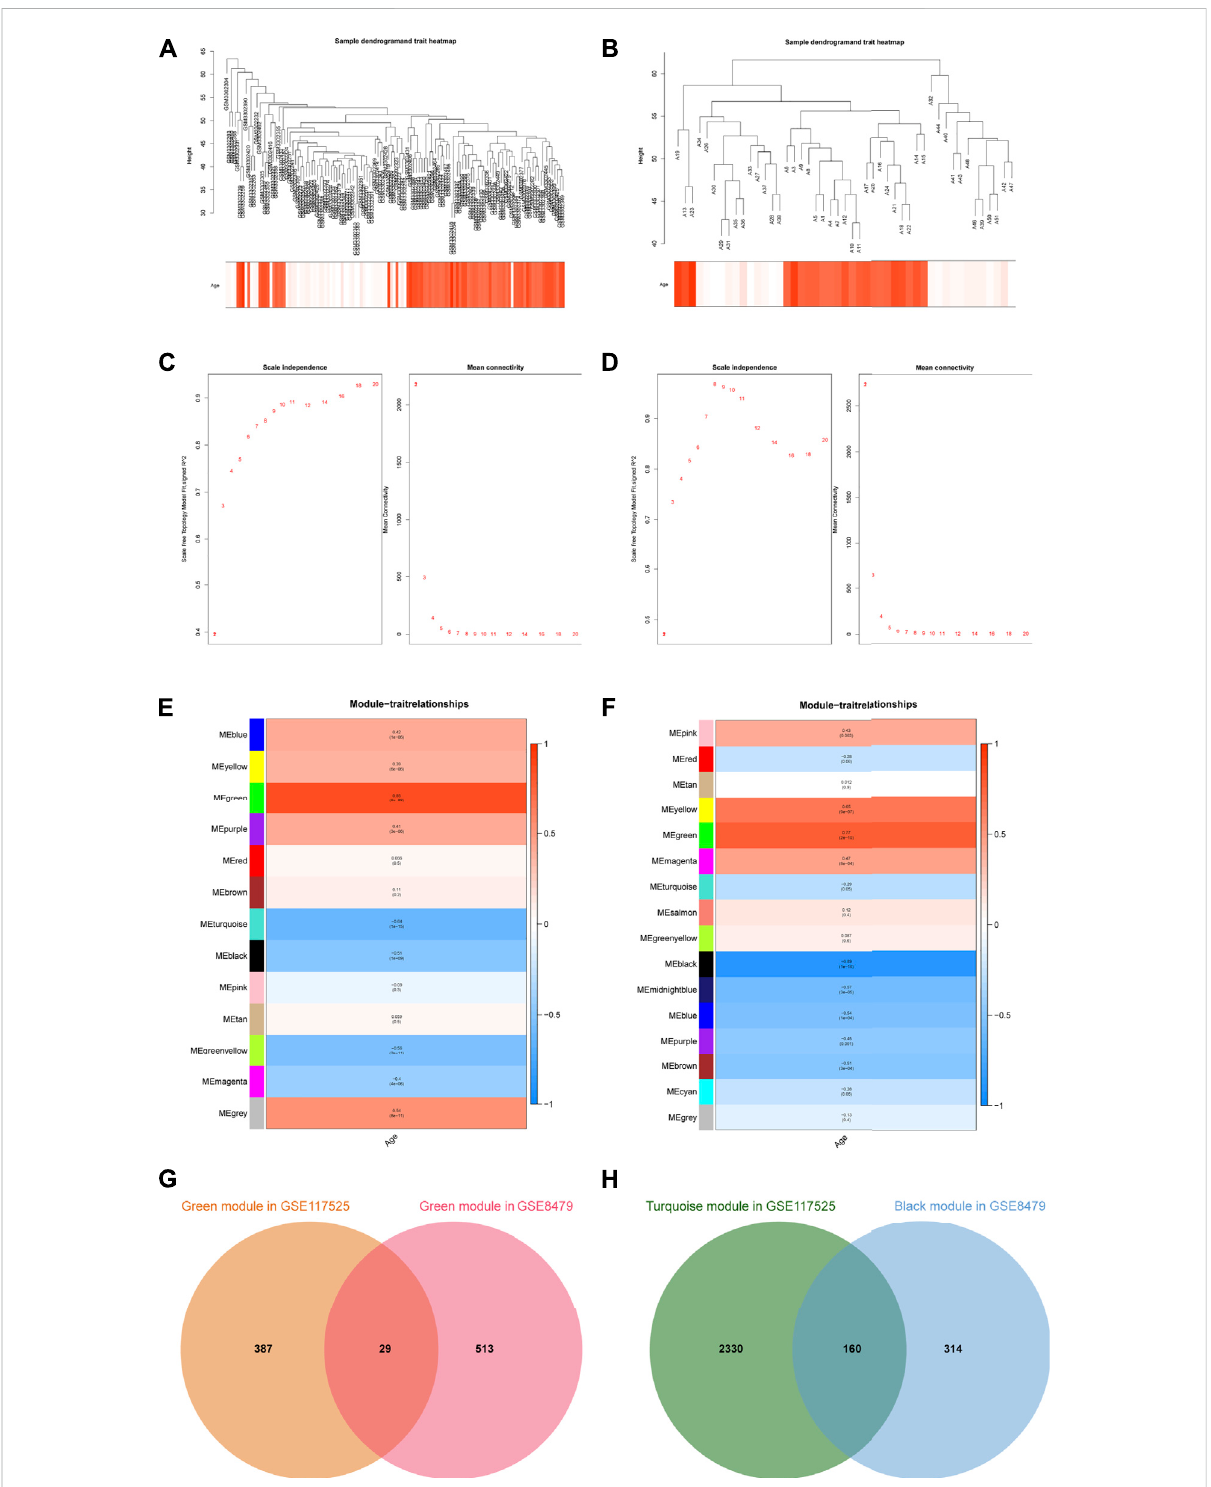
FIGURE 1 The key modules and hub genes identi fi ed by WGCNA. (A,B) Sample clustering after outliers were removed in GSE117525 (A) and GSE8479 (B) . (C,D) The soft-threshold power selecting processes. The β = 7 in GSE117525 (C) and β = 6 in GSE8479 (D) were selected when R 2 reached 0.85. (E,F) Heatmaps of the correlation between module eigengenes and age in GSE117525 (E) and GSE8479 (F) . The corresponding correlations and p -values were presented. (G) The overlapped genes between the green modules. (H) The overlapped genes between the turquoise module and black